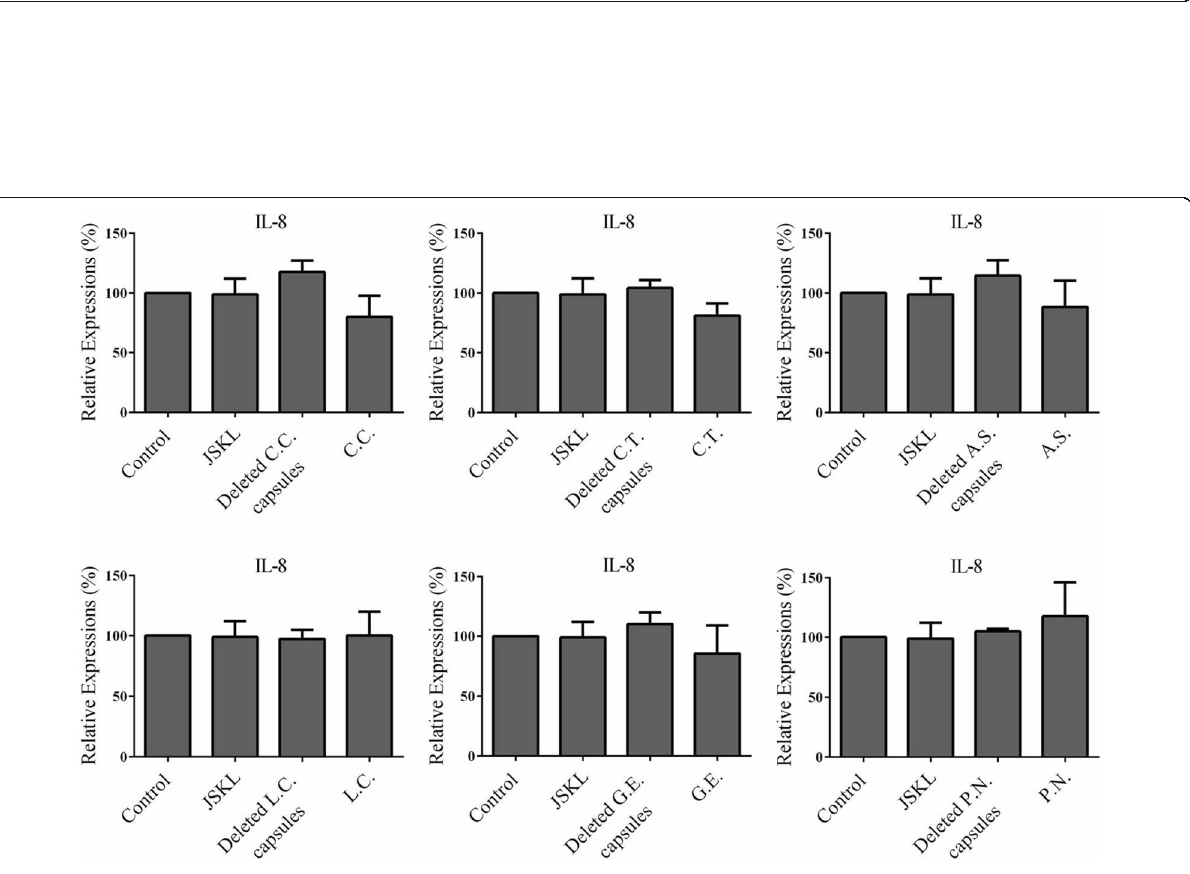
Fig. 5 Effect of JSKL, deleted-herb-capsule and single-herb-capsule on the expression of IL-8 in LPS-stimulated MH7A